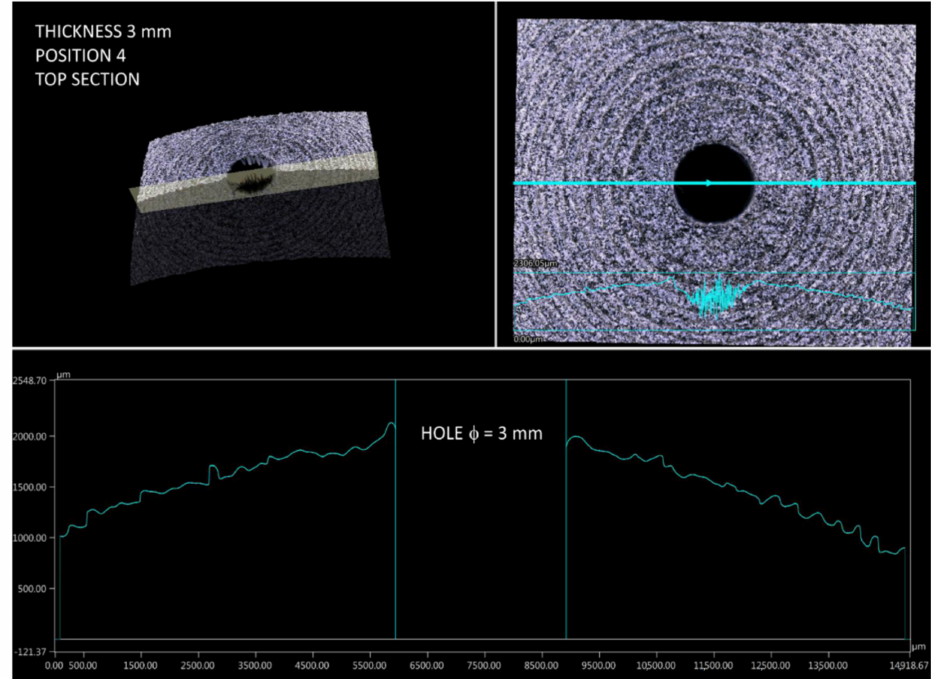
Figure 16. Surface profile of part 4.3 (top